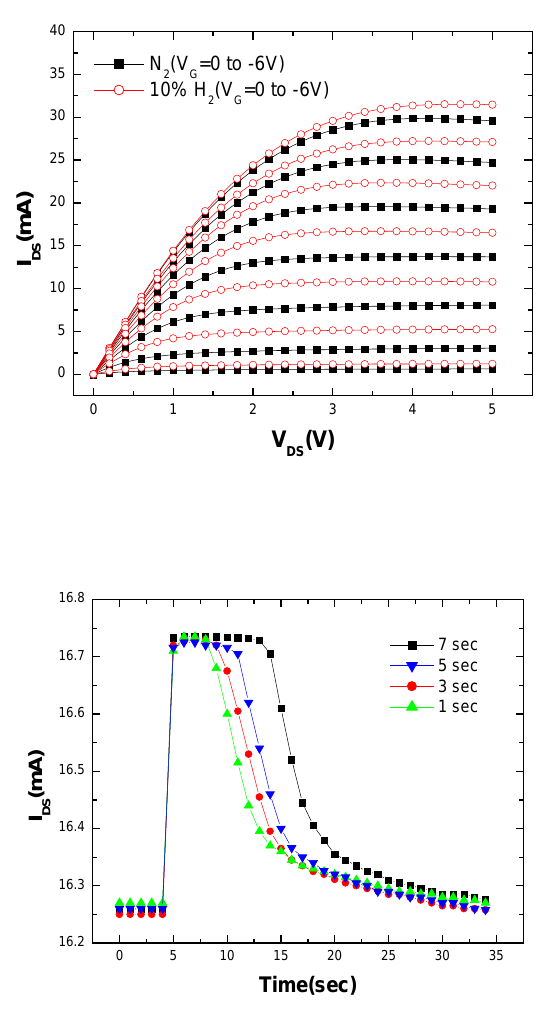
Figure 5. I -V characteristics of MOS-HEMT measured at 25°C under pure N DS DS H /90%N ambient(top) and time dependence of drain-source current when switching from N 2 2 10%H /90% N ambient and back again for different injection times of the H 2 2